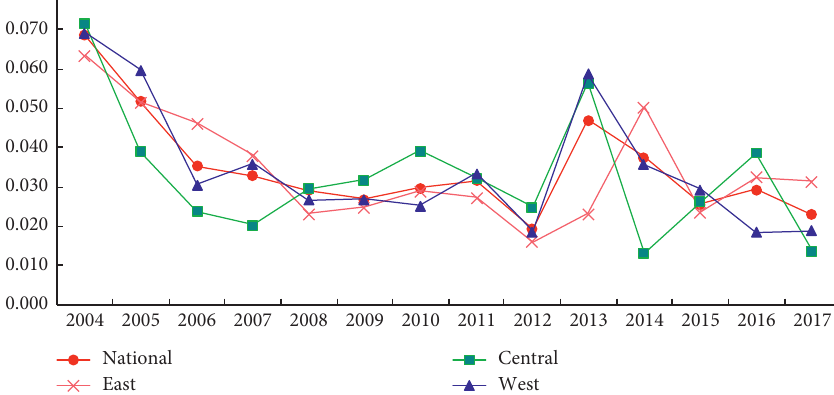
Figure 1: The change trend of regional differences in green TFP of logistics industry in China and three regions.